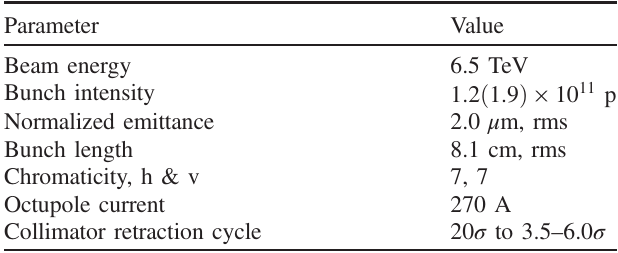
TABLE I. Key parameters of the measurement with nominal intensity LHC beam (in parenthesis — for a high-intensity beam). In collimator settings, σ is the beam size for a 3 . 5 μ m reference normalized emittance.